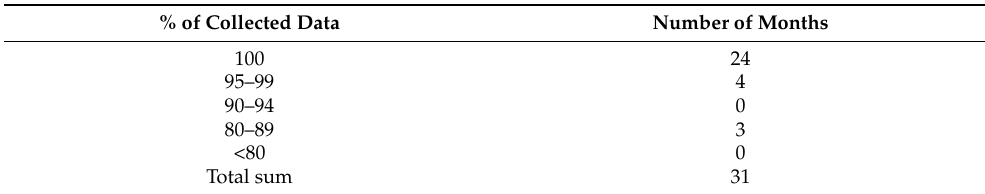
Table 3. Completeness of GNSS data collection at station TVRN over individual months between October 2019 and April